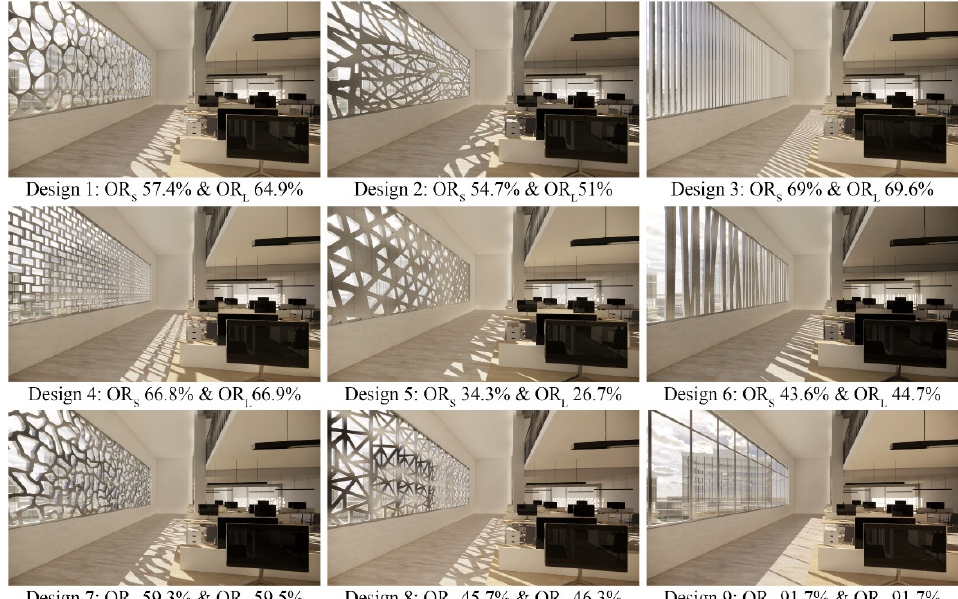
Figure 4. Nine aperture designs with the large window under the clear sky (OR S represents the openness ratio for the small window, and OR L represents the openness ratio for the large window.).